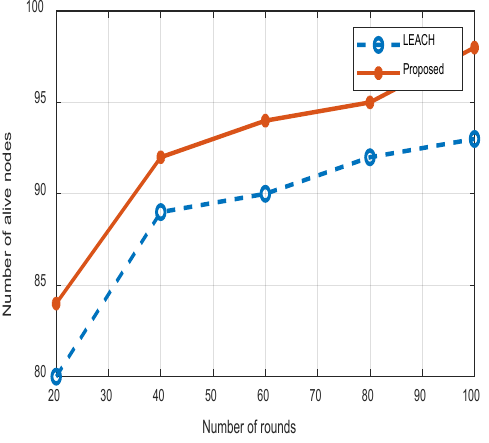
Figure 6. Comparison of Number of Rounds Vs Alive